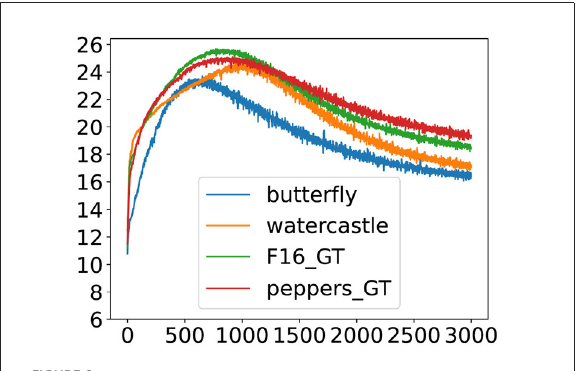
FIGURE3 One of the experiments with the best results for all four images. This figure shows the PSNR curve. An example of the semiconvergence phenomenon.